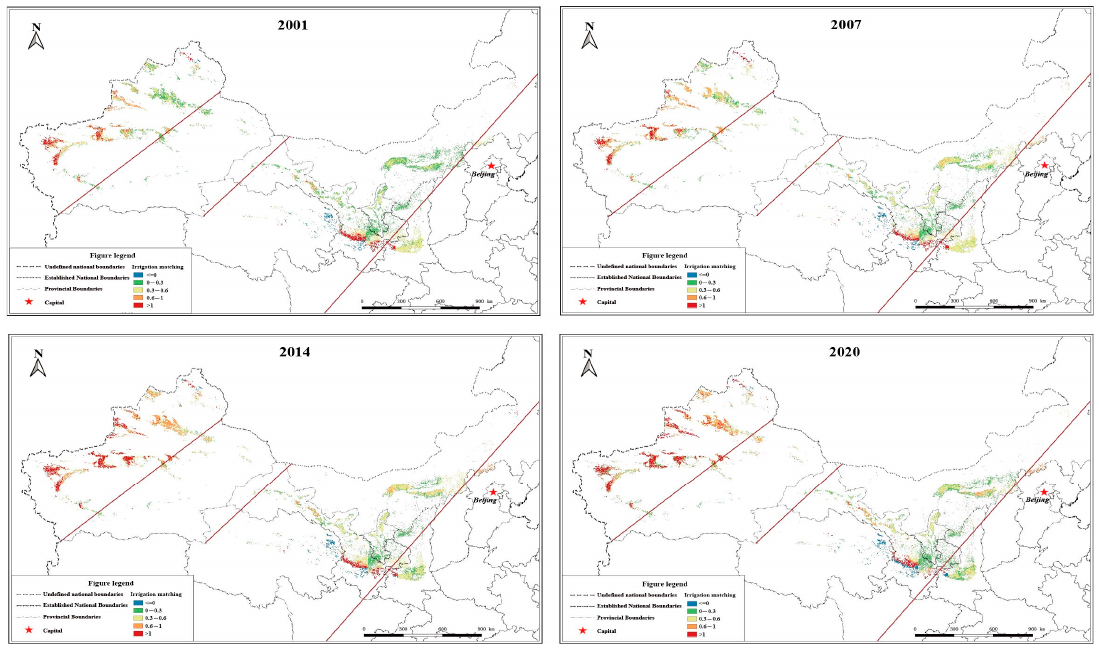
Figure 7. Spatial distribution of IGCI in northwest ‘Three Water Lines’ area.